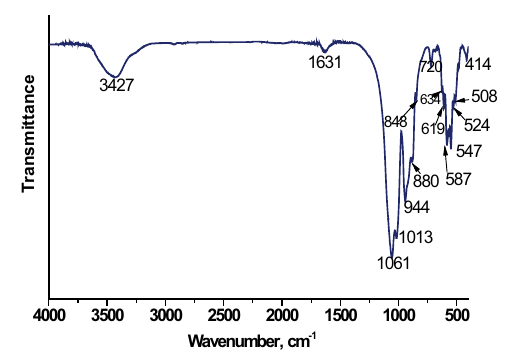
Figure 2. FTIR spectrum of silicocarnotite, heat treated at 1200 o C / 2 h